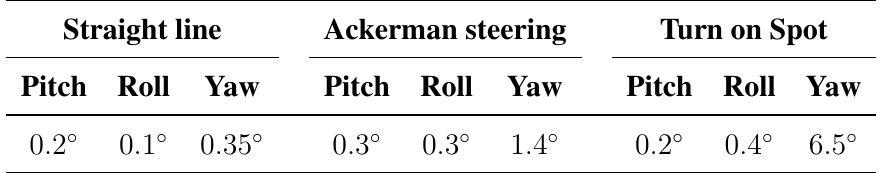
Table 6. Maximum attitude errors for the proposed fusion scheme during tests on the